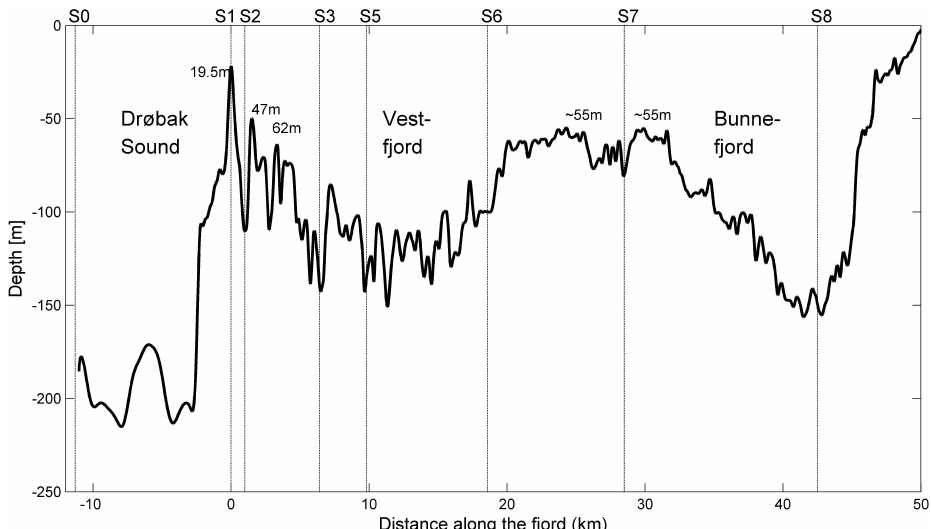
Fig. 2. Depth profile along the fjord following the deepest parts from the Drøbak Sound, on the east side of H˚aøya Island to the inner parts of the Bunnefjord. Vertical dashed lines indicate the positions of the stations along this line. The most important sills – the Drøbak Sill (19.5m), the Godthol Sill (47m), the Tronstad Sill (62m) and the two sills between the Vestfjord and the Bunnefjord (55m) – are marked with their